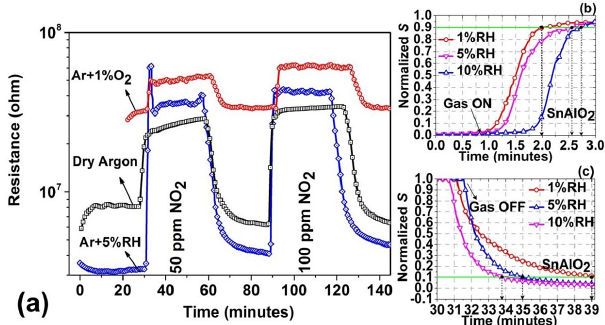
exposed to 50 and 100ppm of NO 2 gas concentrations in dry argon, argon with 1% oxygen and argon with 5% RH in the background, measured at T w = 600 ◦ C. (b) and (c) provide a detailed view of the time-dependent normalized sensor response given on the right-hand side (Normalized S = [ R ( t ) – R (Ar) /R (NO – R (Ar) ]) after the gas 2 ) was switched ON and OFF. Here, R ( t ) , R (Ar) and R (NO denote 2 ) real-time resistance, resistance in argon and NO 2 gas, respectively.